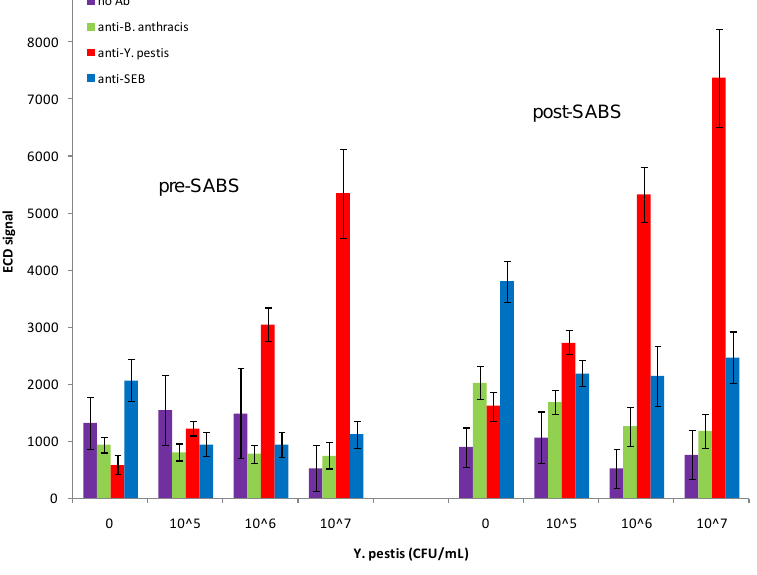
Figure 6. Y. pestis assay in 50% serum. Chips were incubated with 0, 10 5 , 10 6 , or 10 7 CFU/mL inactivated Y. pestis diluted in 50% human serum. Anti- B. anthracis , anti- Y. pestis , and anti-SEB refer to the antibodies immobilized on the chip surface. Mean signals and SD are